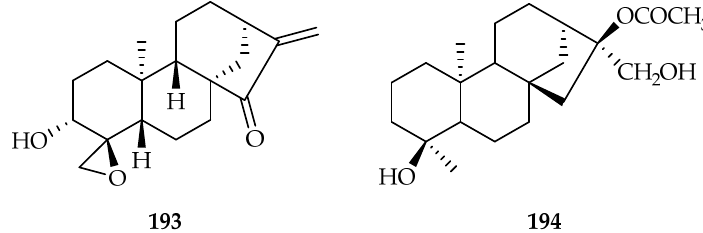
Figure 79. Structures of amentotaxin C 193 [55] and compound 194